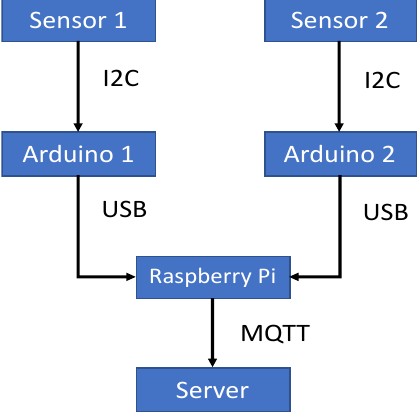
Figure 1. Connection diagram of two sensors to the